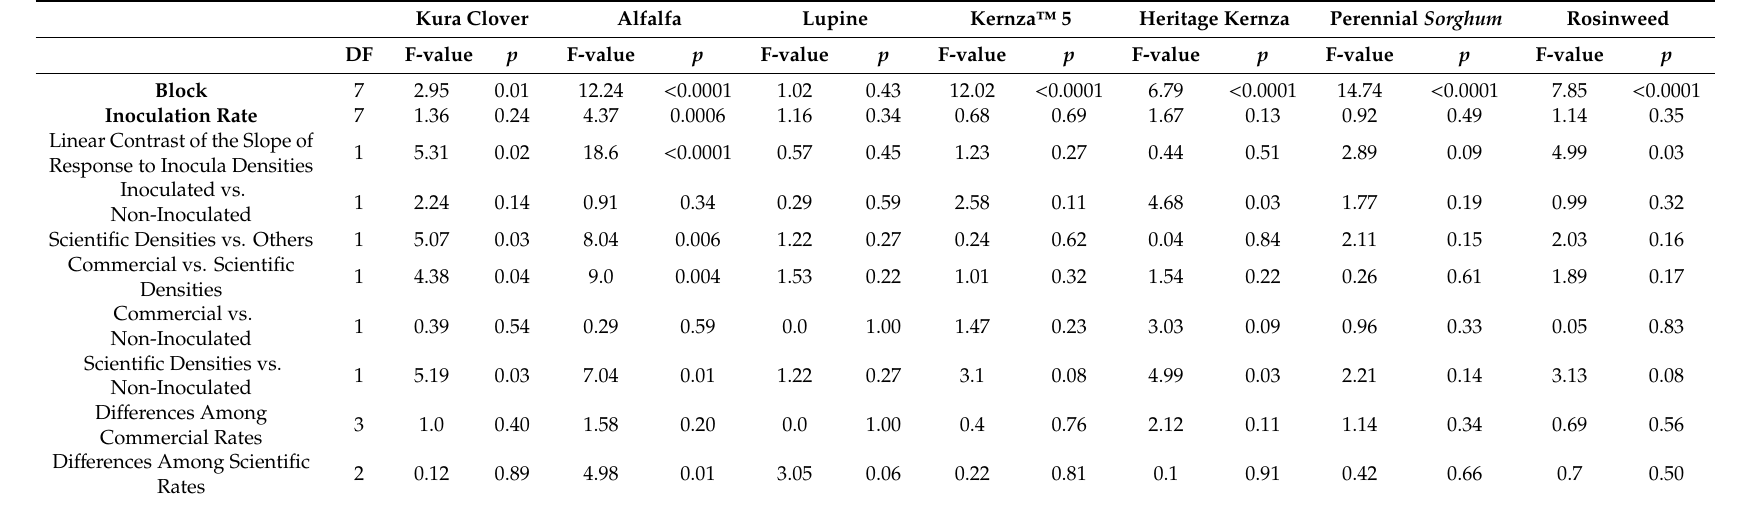
Table 3. Plant growth in the field (either plant biomass or size) was strongly dependent on inoculation rate for some plant species, but not others. Contrasts were used to test whether each plant di ff ered in growth response to di ff erent densities of mycorrhizal inoculation, including across and within the categories of having no inocula amendment, adding the low densities recommended by commercial producers of inocula, or adding the high density of mycorrhizal inocula often reported in the scientific literature. A linear contrast was also designed to test if plant response to inoculation was increasing predictable with inoculation